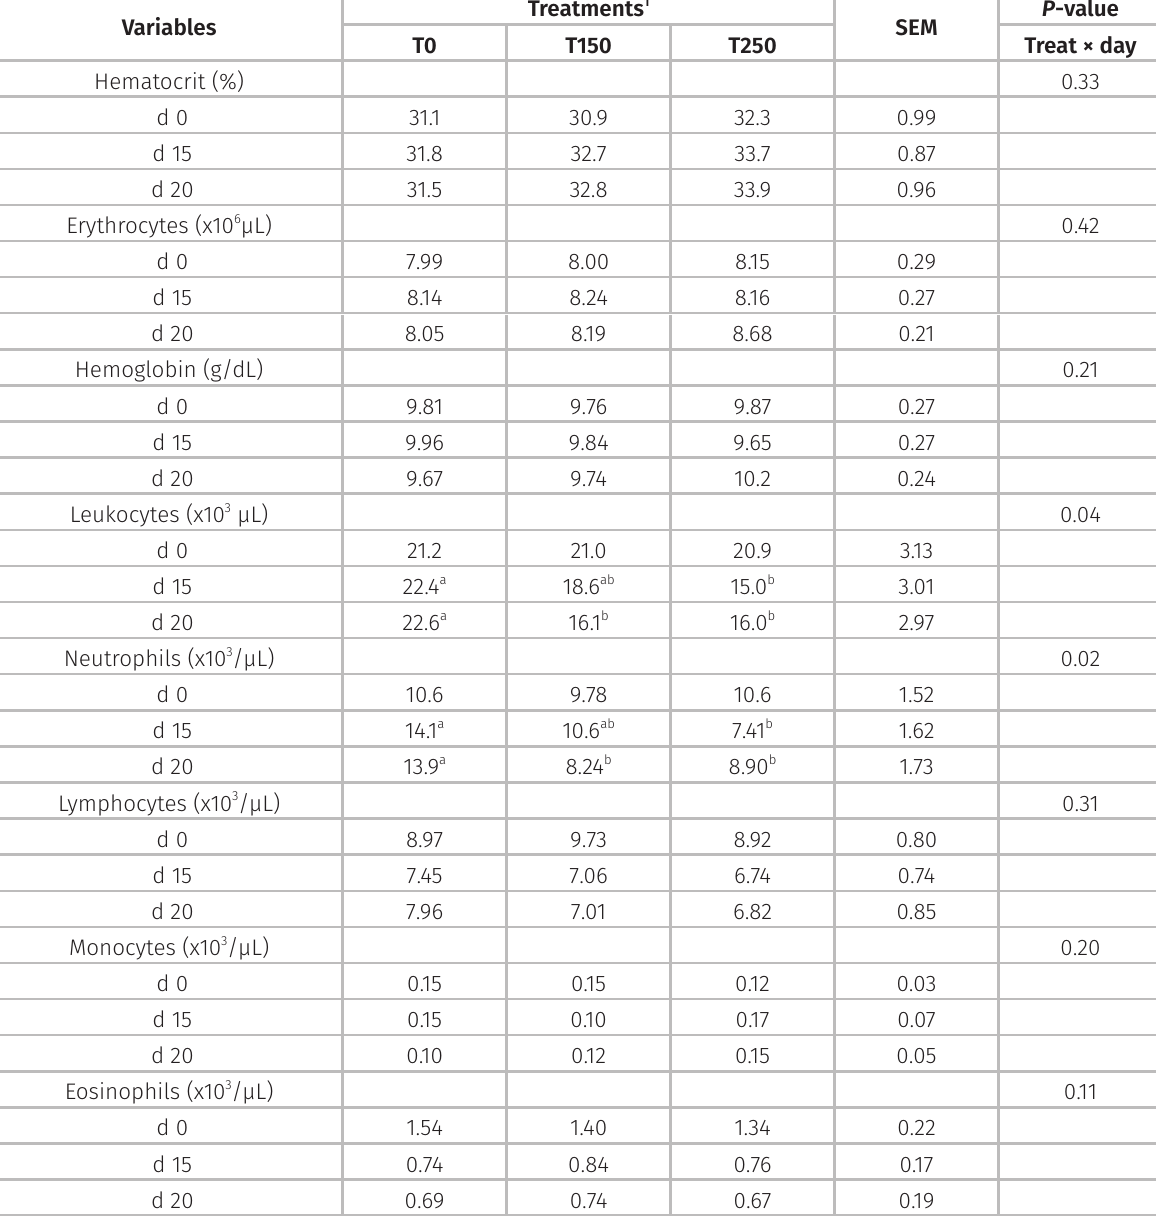
Table IV. Hemogram of Lacaune ewes supplemented with dietary phytogenic. Treatments 1 Variables